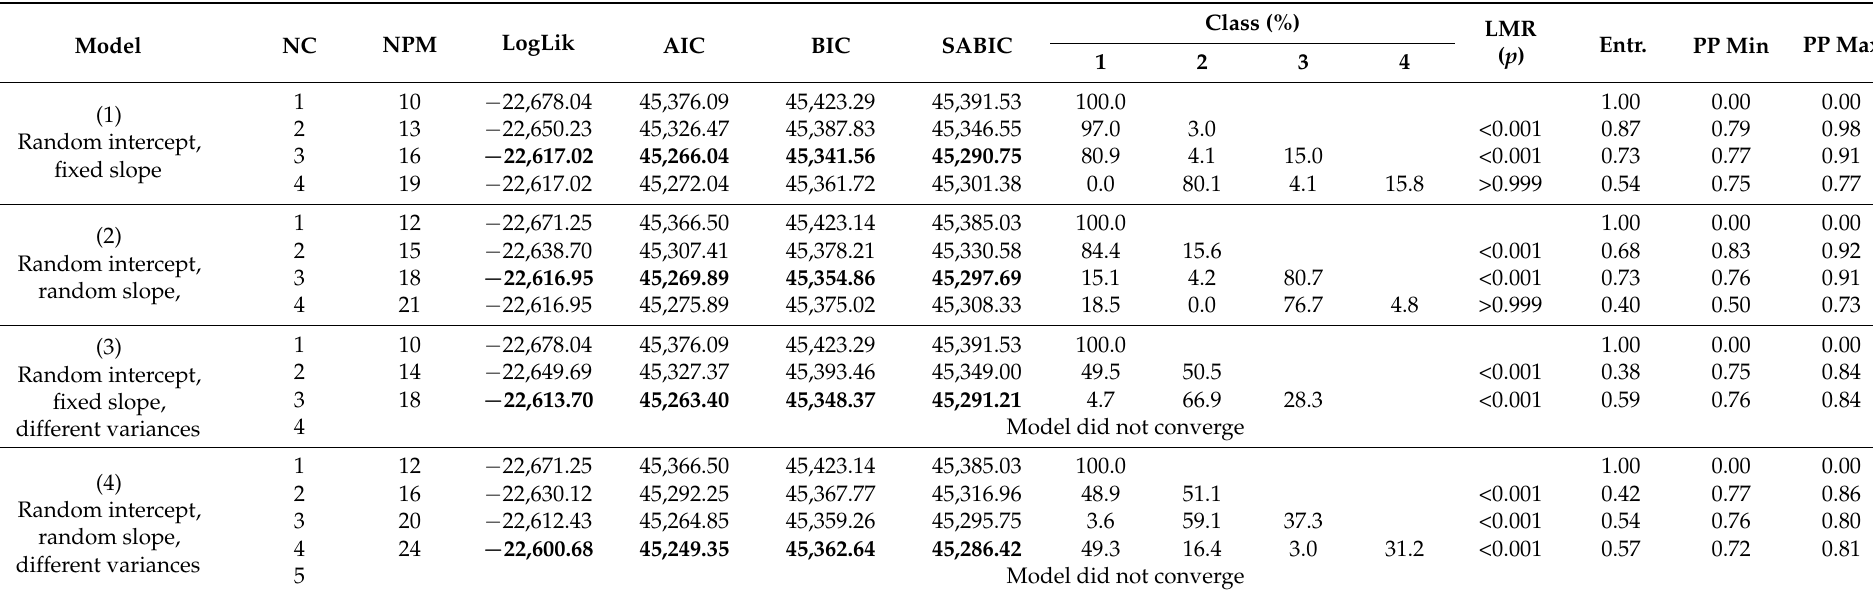
Table A6. Multivariate Latent Class Growth Analysis for QoLIBRI-OS and SF-12v2 MCS/PCS for participants with complicated mild TBI (N =